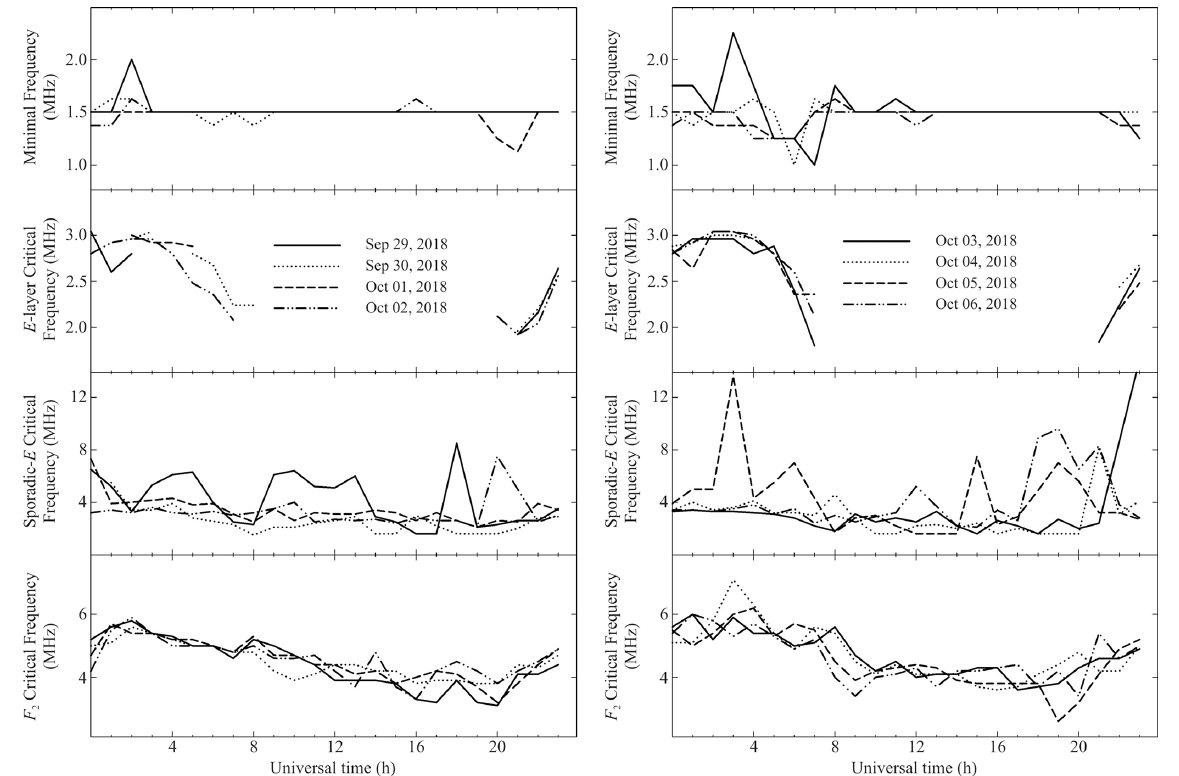
Figure 3. Universal time variations in ionogram parameters determined with an update rate of one measurement per 1h: minimum frequency, f min , observed on the ionograms, and critical frequencies fo E, fo E s , and fo F2 for the 29 September–2 October and 3–6 October 2018